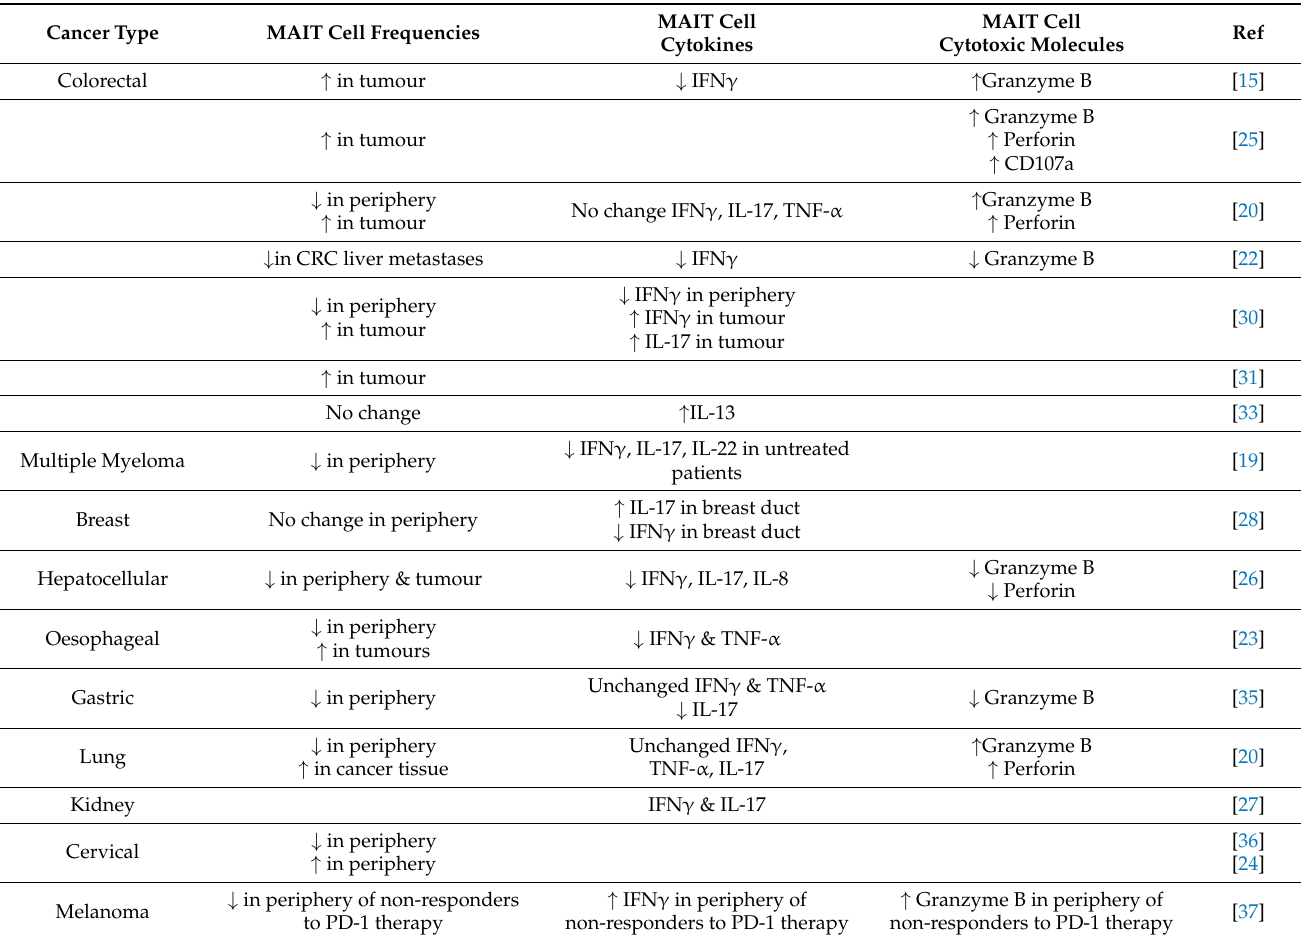
Table 1. Overview of MAIT cell frequencies, cytokine profile and cytotoxic molecule production in cancer. Cancer